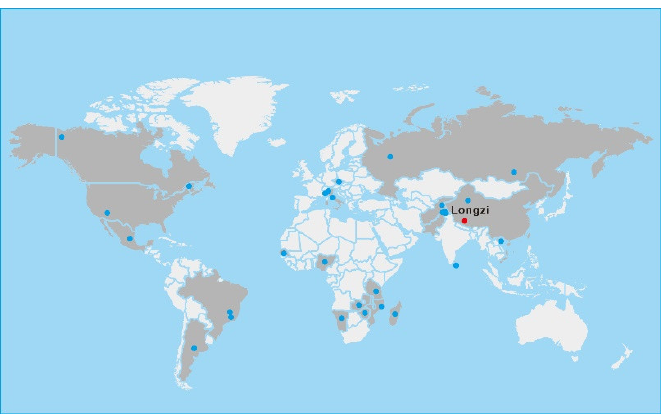
Figure 1. Aquamarine-producing areas (grey parts). The red dot locates Longzi County. Other sources are [2–22].